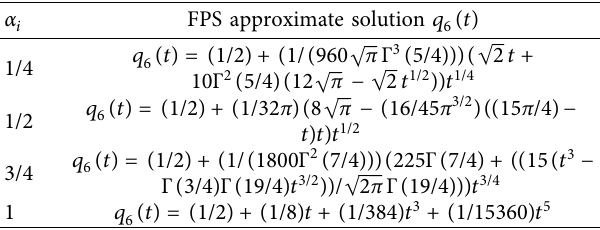
Table 4: Representation of approximate solutions for different values of α .